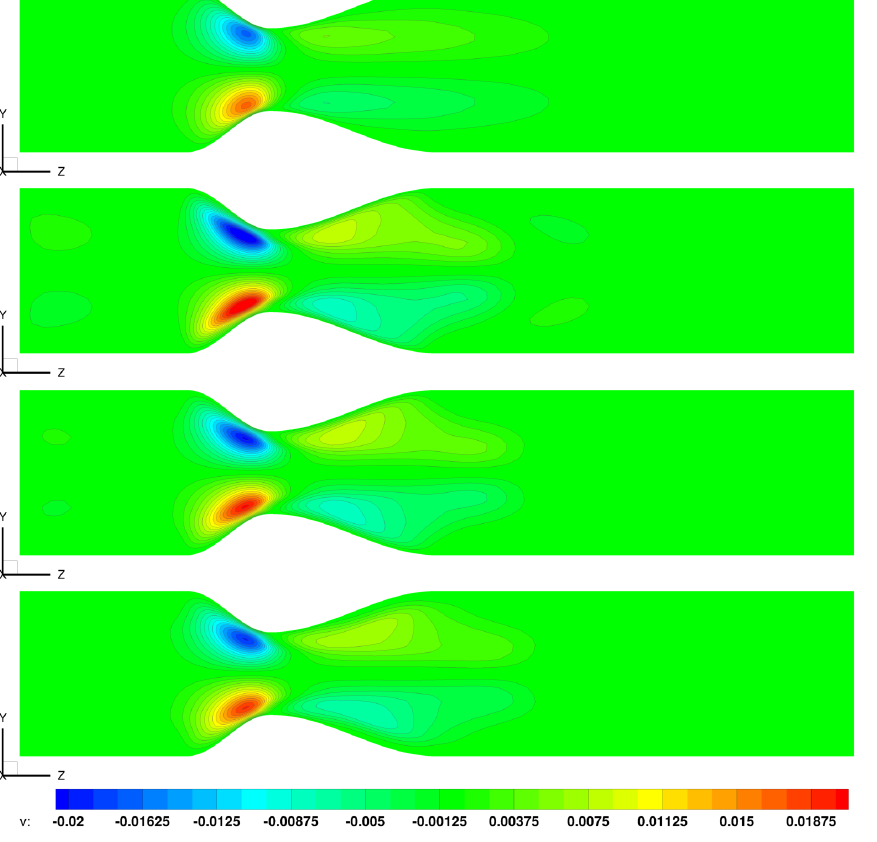
Figure 18. Radial velocity at flow rate Q = 0.5 cm 3 /s—GOB (top figure) and Johnson–Segalman models for a = − 0.9, a = − 0.8, a = − 0.7 (from the